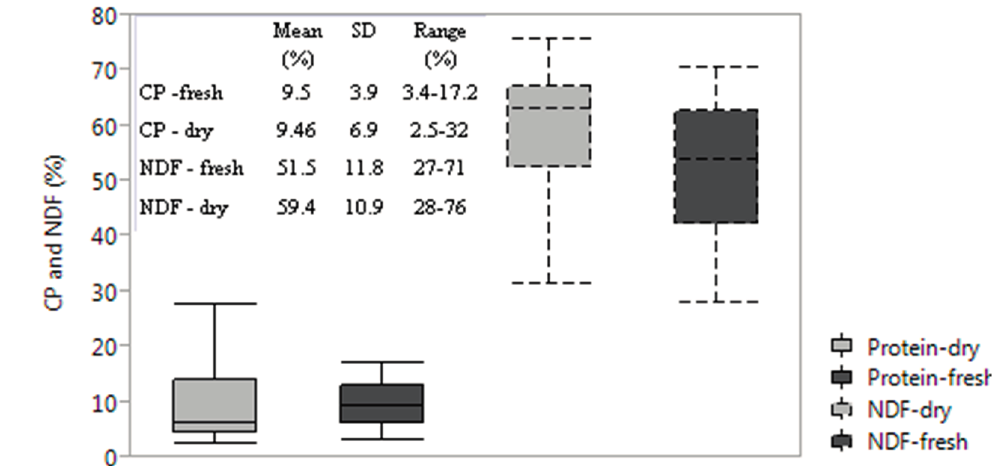
Figure 2. Distribution of crude protein (%CP) and neutral detergent fiber (%NDF) contents in dry and fresh